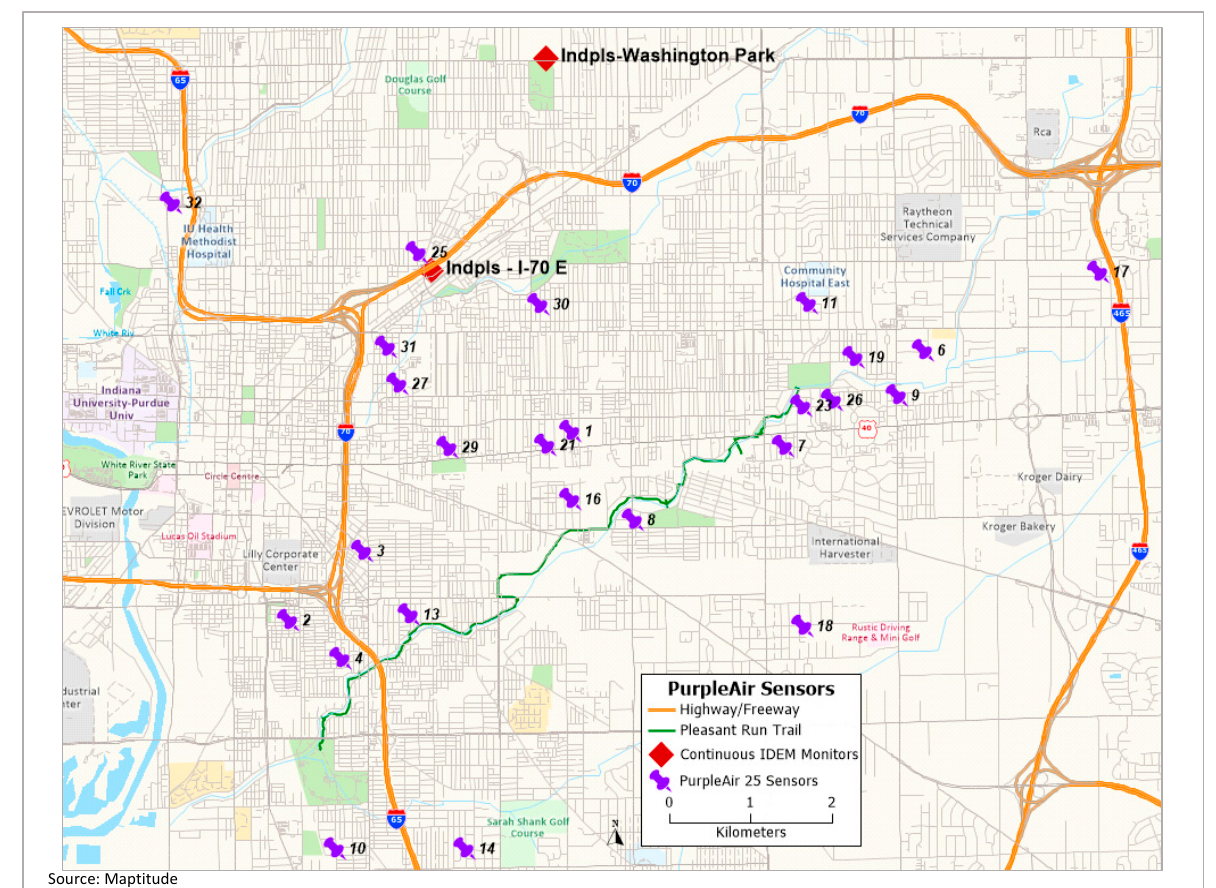
Figure 1. Locations of 25 PA sensors in the study area.